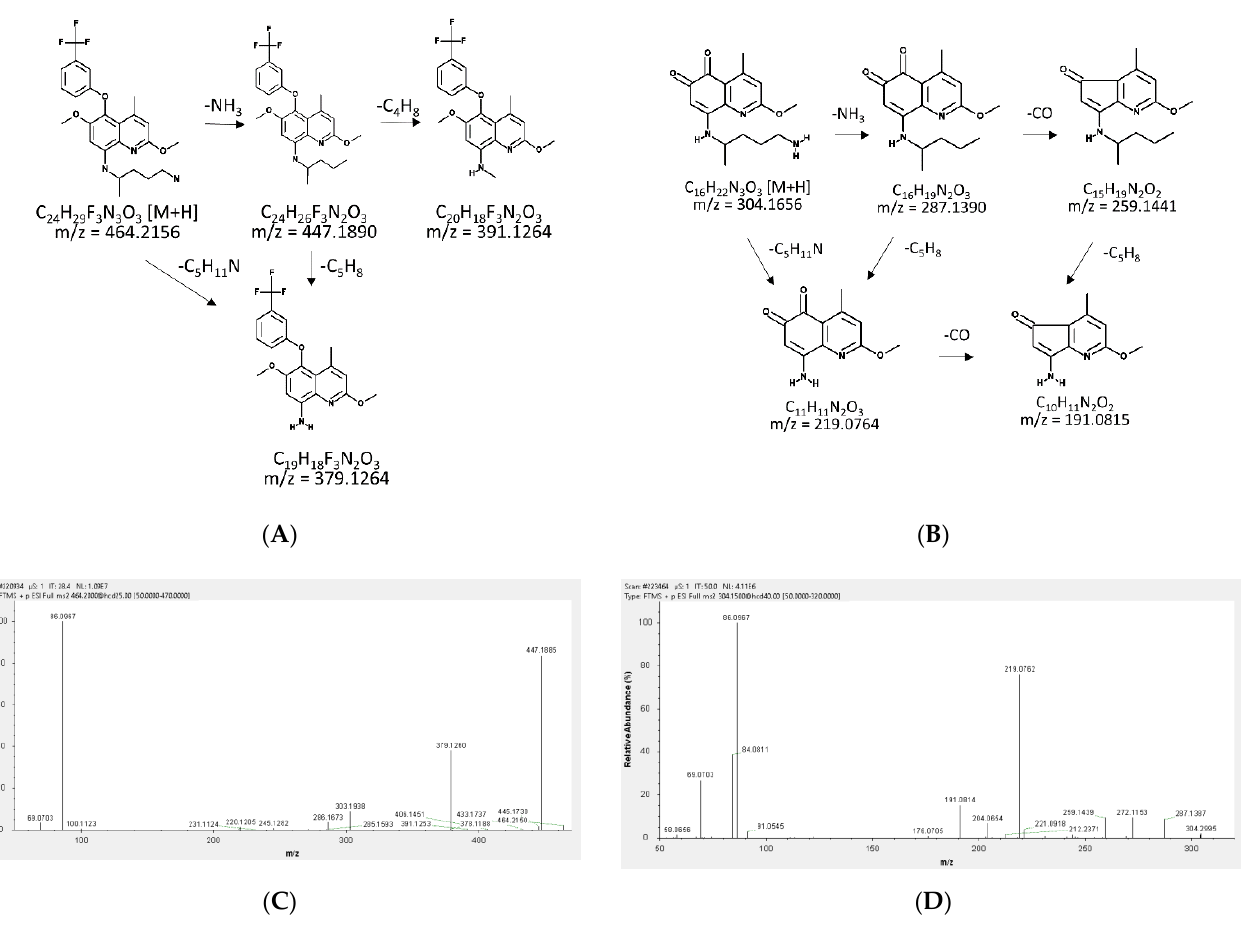
Figure 1. The predicted fragmentation patterns and the MS/MS spectra of tafenoquine (TQ) and 5,6-orthoquinone tafenoquine (5,6-OQTQ). The predicted fragmentation patterns of ( A ) TQ; and ( B ) 5,6-OQTQ. The MS/MS spectra of ( C ) TQ showed the key fragments at m/z 379.13 (predicted 379.1265, observed 379.1260, mass error − 1.0551), m/z 447.19 (predicted 447.1890, observed 447.1885, mass error − 1.1181), and m/z 391.13 (predicted 39.1264, observed 391.1253, mass error − 2.8124); and ( D ) 5,6-OQTQ showed the key fragments at m / z 287.14 (predicted 287.1390, observed 287.1387, mass error − 1.0448), m/z 259.14 (predicted 259.1441, observed 259.1439, mass error − 0.7718) and m / z 219.08 (predicted 219.0764, observed 219.0762, mass error − 0.9129). These MS/MS scans were from the FTMS (Fourier transform mass spectrometer) QExactive Plus (Thermo Fisher, Waltham, MA, USA) positive mode scans at 70,000